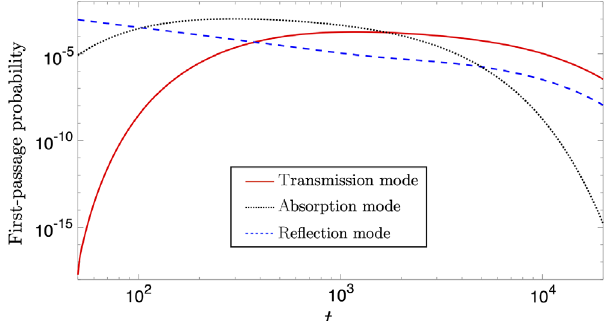
FIG. 2. Time dependence of the first-passage probability in a 1D domain of size N ¼ 51 with q ¼ 0 . 7 . The curve in t Þ in Eq. (C5) the absorption mode is the plot of E n 0 → ð 1; N Þ ð with n 0 ¼ 25 . The reflection and transmission modes display F ð r Þ n ð N; t Þ from Eq. (C2) with, respectively, n 0 ¼ 5 and n 0 ¼ 50 . 0 The reflection mode exhibits a power-law dependence in time, whereas an exponential dependence is present for the trans- mission and absorption